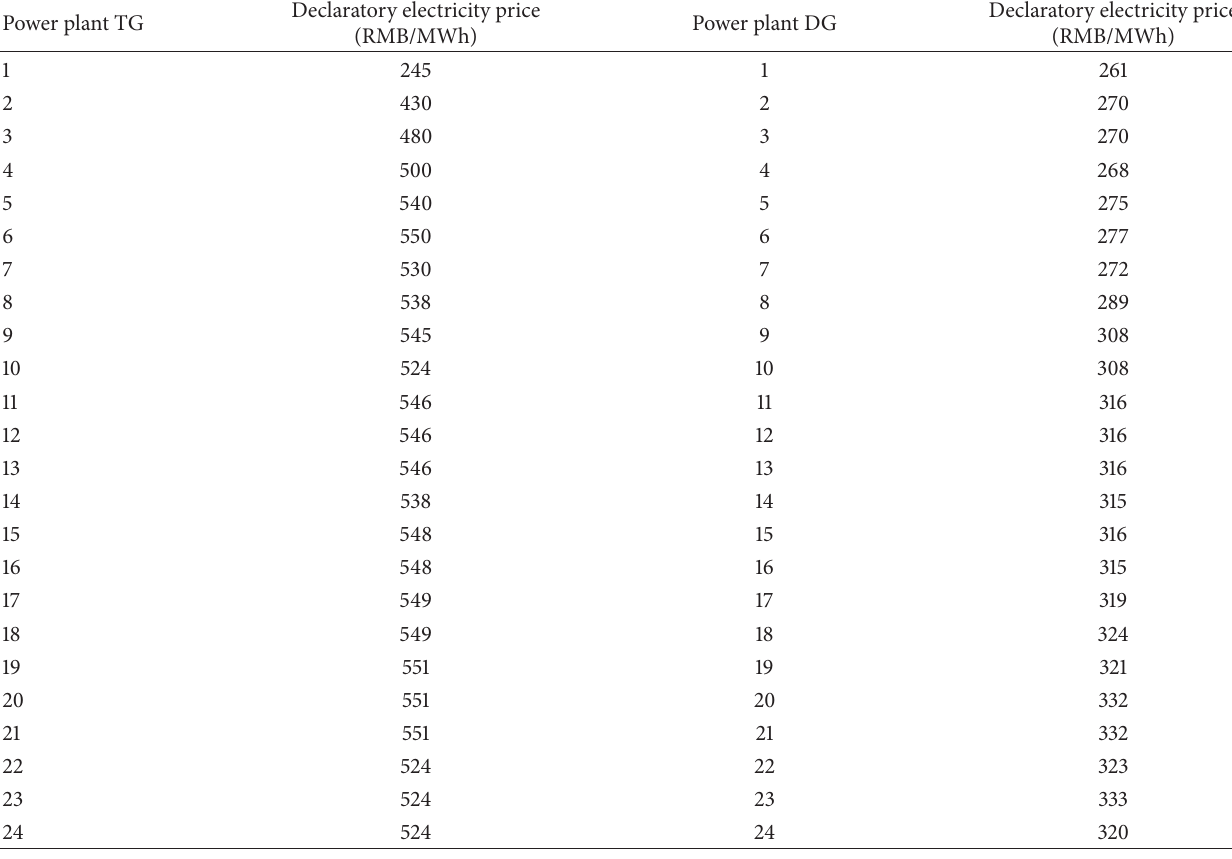
Table 3: The declaratory electricity price of generating units.